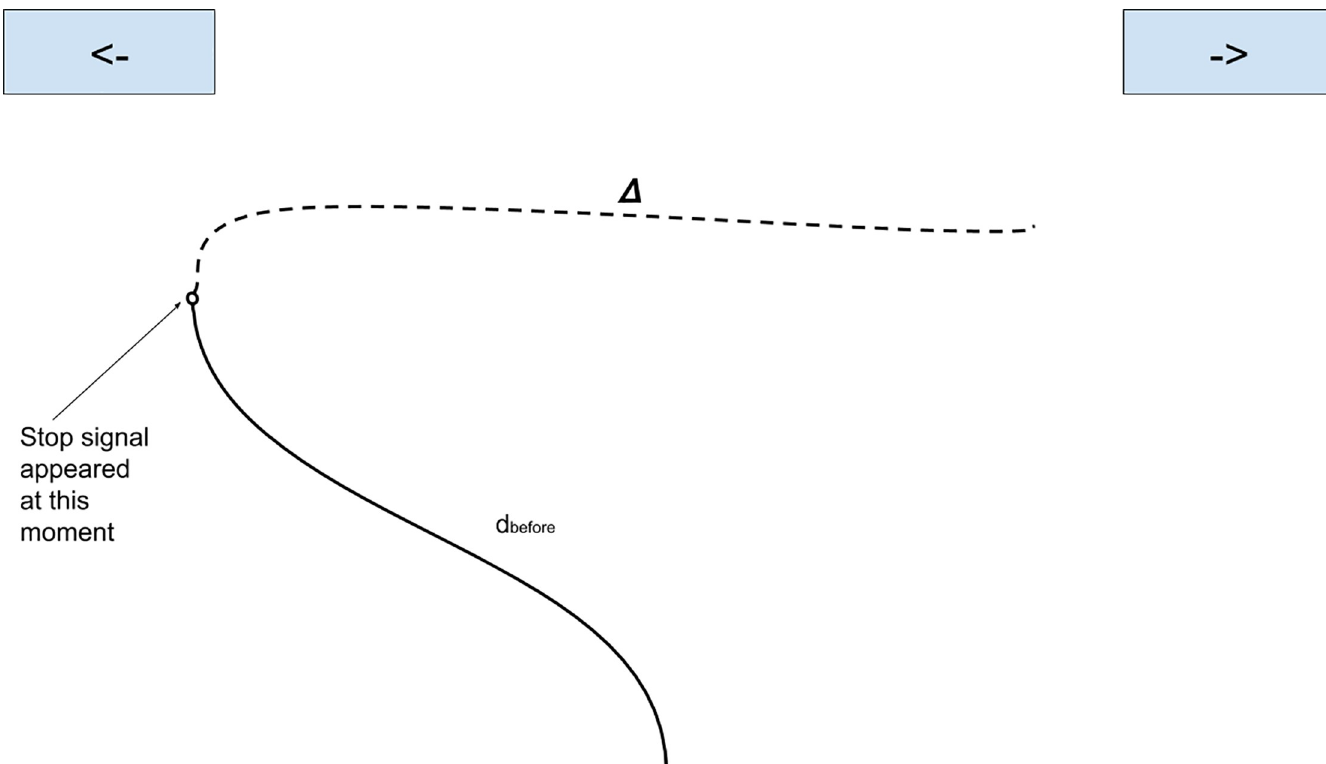
Fig 3. Calculation of stopping distance. Note : in this hypothetical trial, an individual continued to move the mouse for some time after hearing the “stop” signal. Stopping distance ( Δ ) is represented by the dashed line. Distance before stop-signal (d before ) is represented by a solid line.